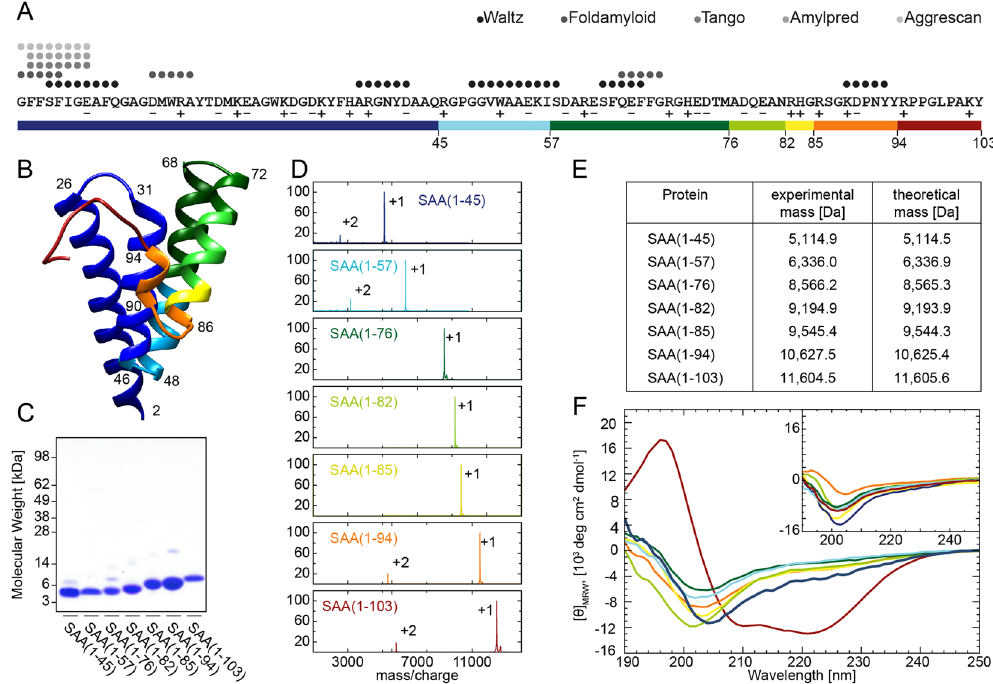
Figure 1. Properties of SAA(1–103) and its AA proteins. ( A ) Residue-specific prediction of amyloid prone regions within murine SAA1.1 protein using five different algorithms as indicated in the panel. Investigated fragments are marked in colors. Red, SAA(1–103); orange, SAA(1–94); yellow, SAA(1–85); light green, SAA(1–82); dark green, SAA(1–76); light blue, SAA(1–57); dark blue, SAA(1–45). Acidic amino acid residues are labeled with plus and basic residues with minus. ( B ) Ribbon representation of a homology model of murine SAA1.1 based on the crystal structure of human SAA1.1 9 (PDB:4IP9). First and last residues of helical secondary structures are labeled in the panel ( C ) Coomassie stained SDS-PAGE of recombinantly produced SAA(1–103) and AA proteins. ( D ) MALDI mass spectra of SAA(1–103) and SAA fragments. Peaks labeled with + 1 represent the [M + H] + ions while peaks labeled with + 2 represent the [M + 2H] 2 + ions. ( E ) Masses of SAA(1–103) and SAA fragments determined by mass spectrometry in comparison to theoretical masses. ( F ) Far-UV CD spectra of SAA(1–103) and investigated fragments at 4 °C and 37 °C (insert). ( A , B , D and F ) use the same color